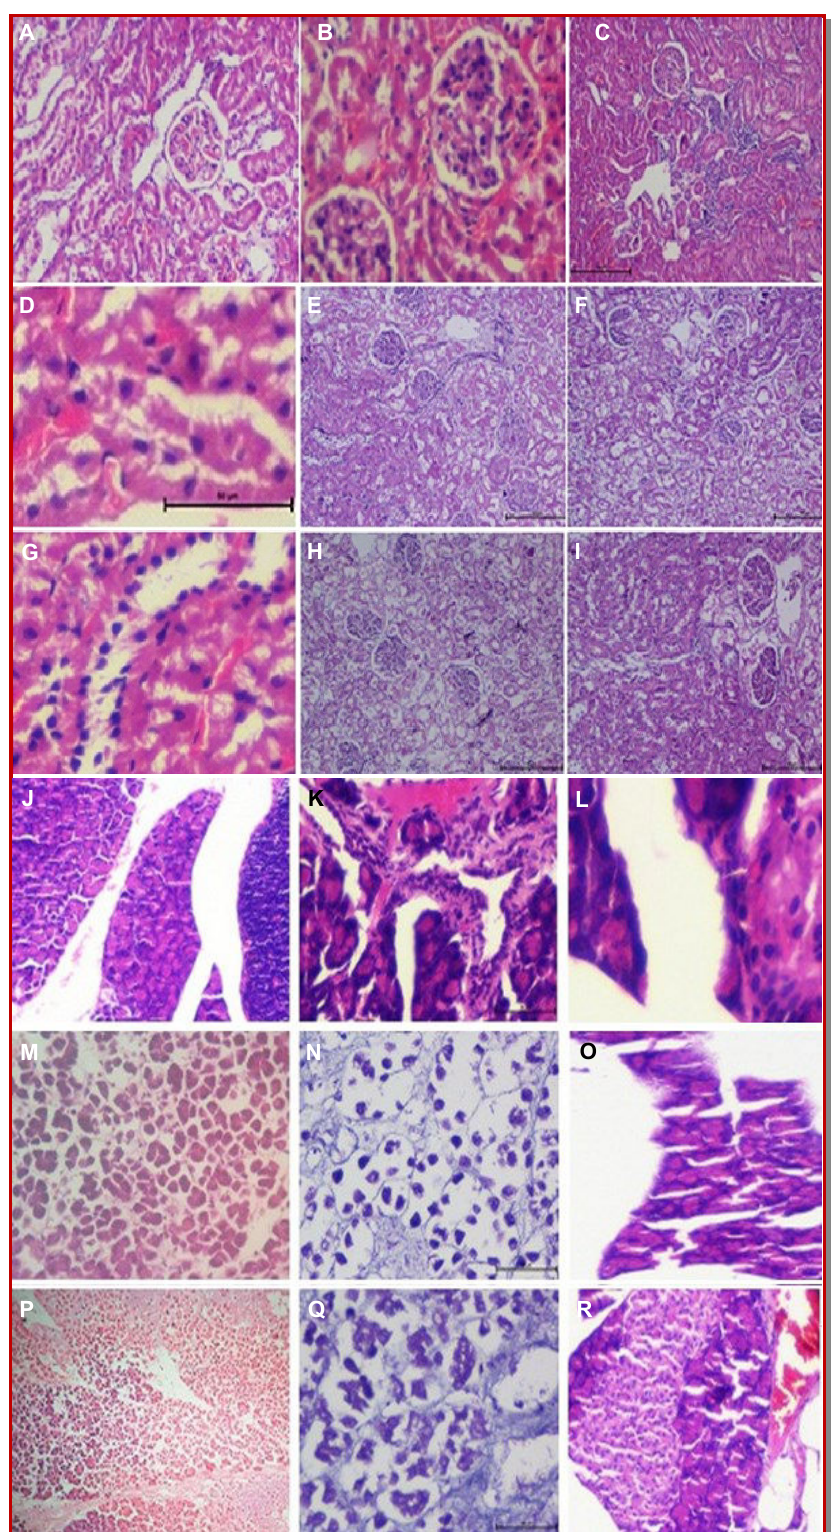
Figure 4: Histopathological changes in kidney and pancreas of normal and treated rats (hematoxylin and eosin 10×); “a” shows the structure of glomerulus. (A, J) normal, (B, K) diabetic nephropathy control, (C, L) standard, (D, M) EP 100 mg/kg treated, (E, N) EP 200 mg/kg, (F, O) EP 400 mg/kg treated, (G, P), EHA 100 mg/kg treated, (H, Q) EHA 200 mg/kg treated and (I, R) EHA 400 mg/kg